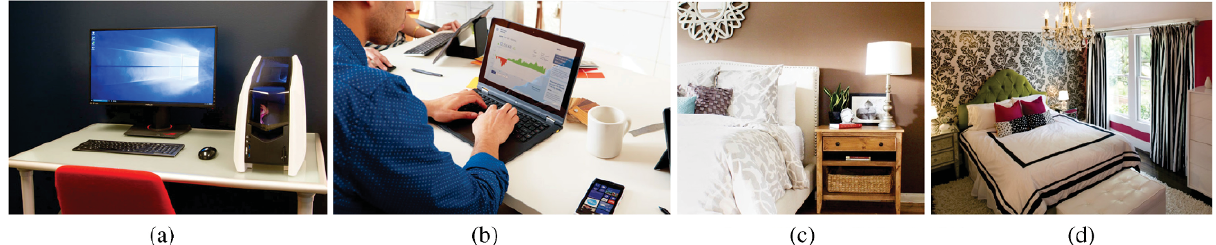
Fig. 2 Ambiguity and imperfection of natural language in describing relative placement. (a, b) Difference between “a monitor on a desk” and “a laptop on a desk”. Although the preposition “on” means “supported by” in both cases, monitors are usually placed far from the user, while laptops are usually placed near the user. (c, d) Difference between “a cabinet beside a bed” and “a window beside a bed”. The preposition “beside” represents different spatial relations in these two scenarios.